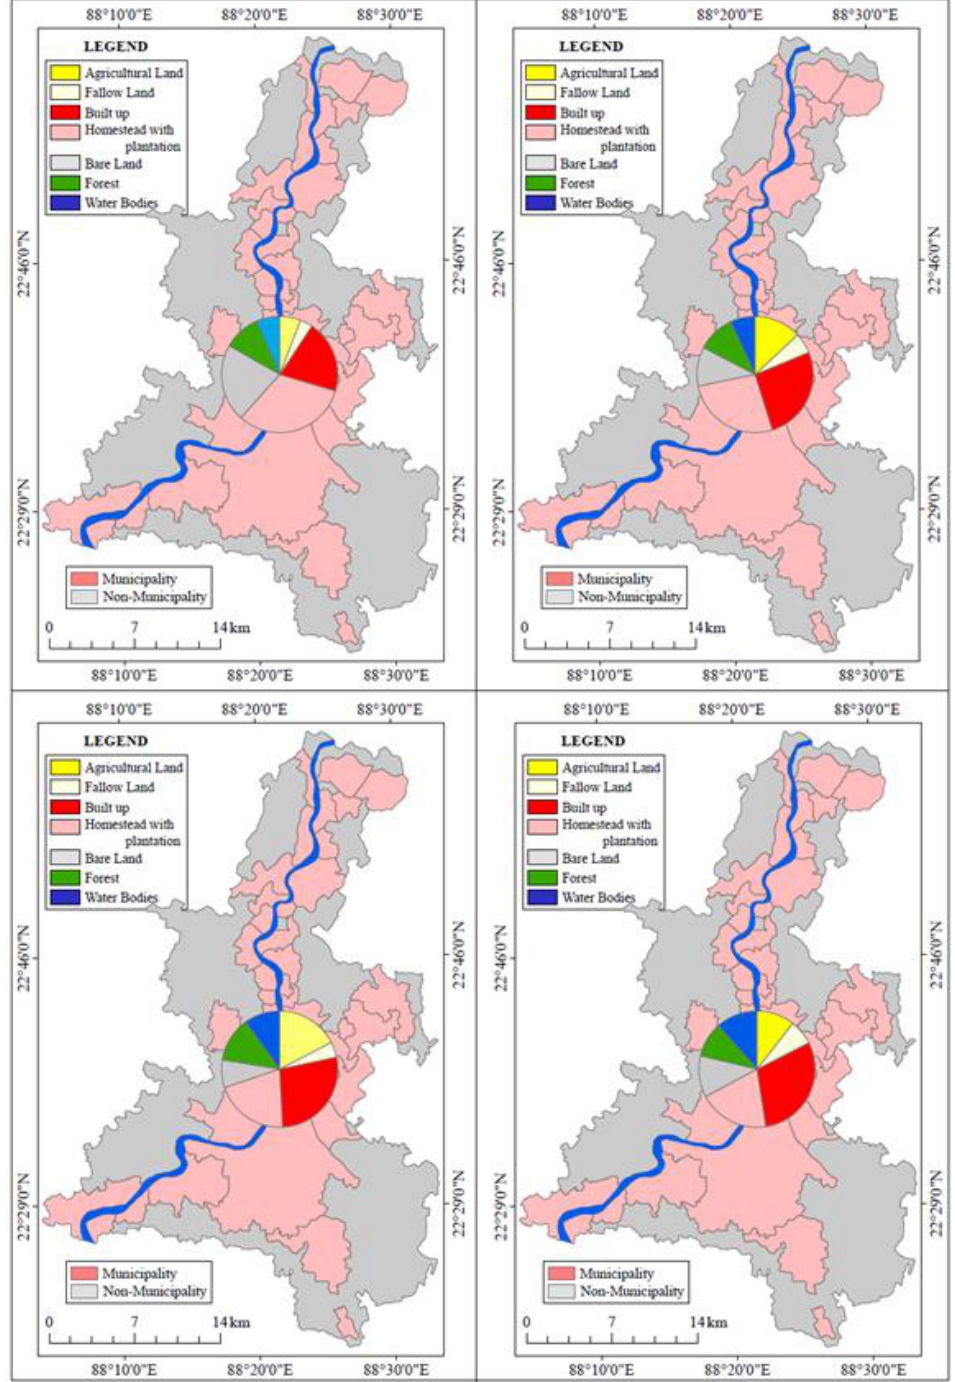
Figure 3. Pie diagram showing the areal accounts on land use and land cover of KMDA for the years 1989, 1999, 2009, and 2019.